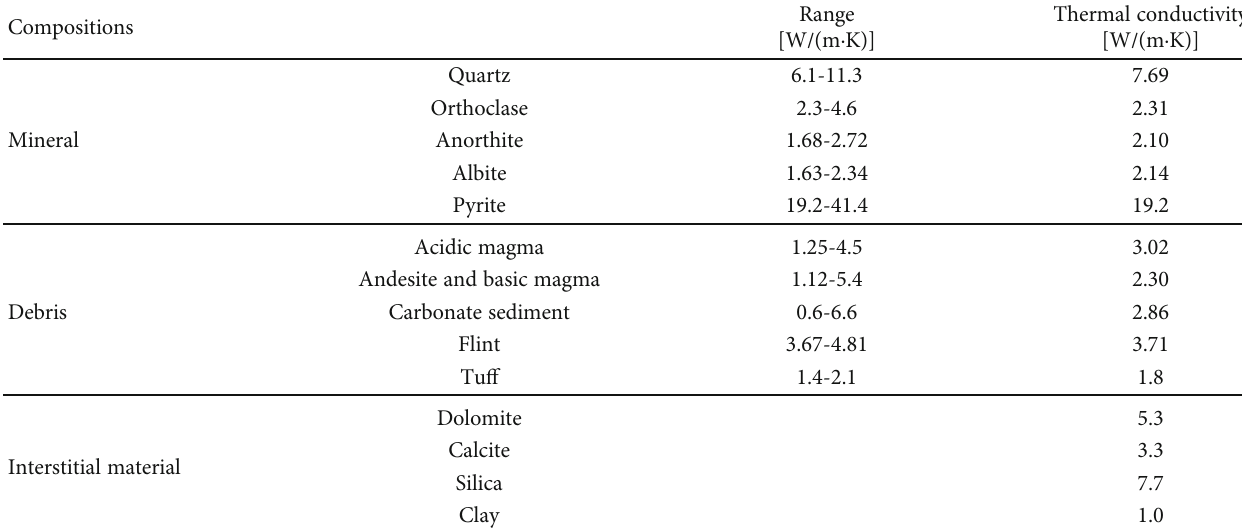
Table 4: Thermal conductivity of the main compositions [17, 45, 48 – 50].